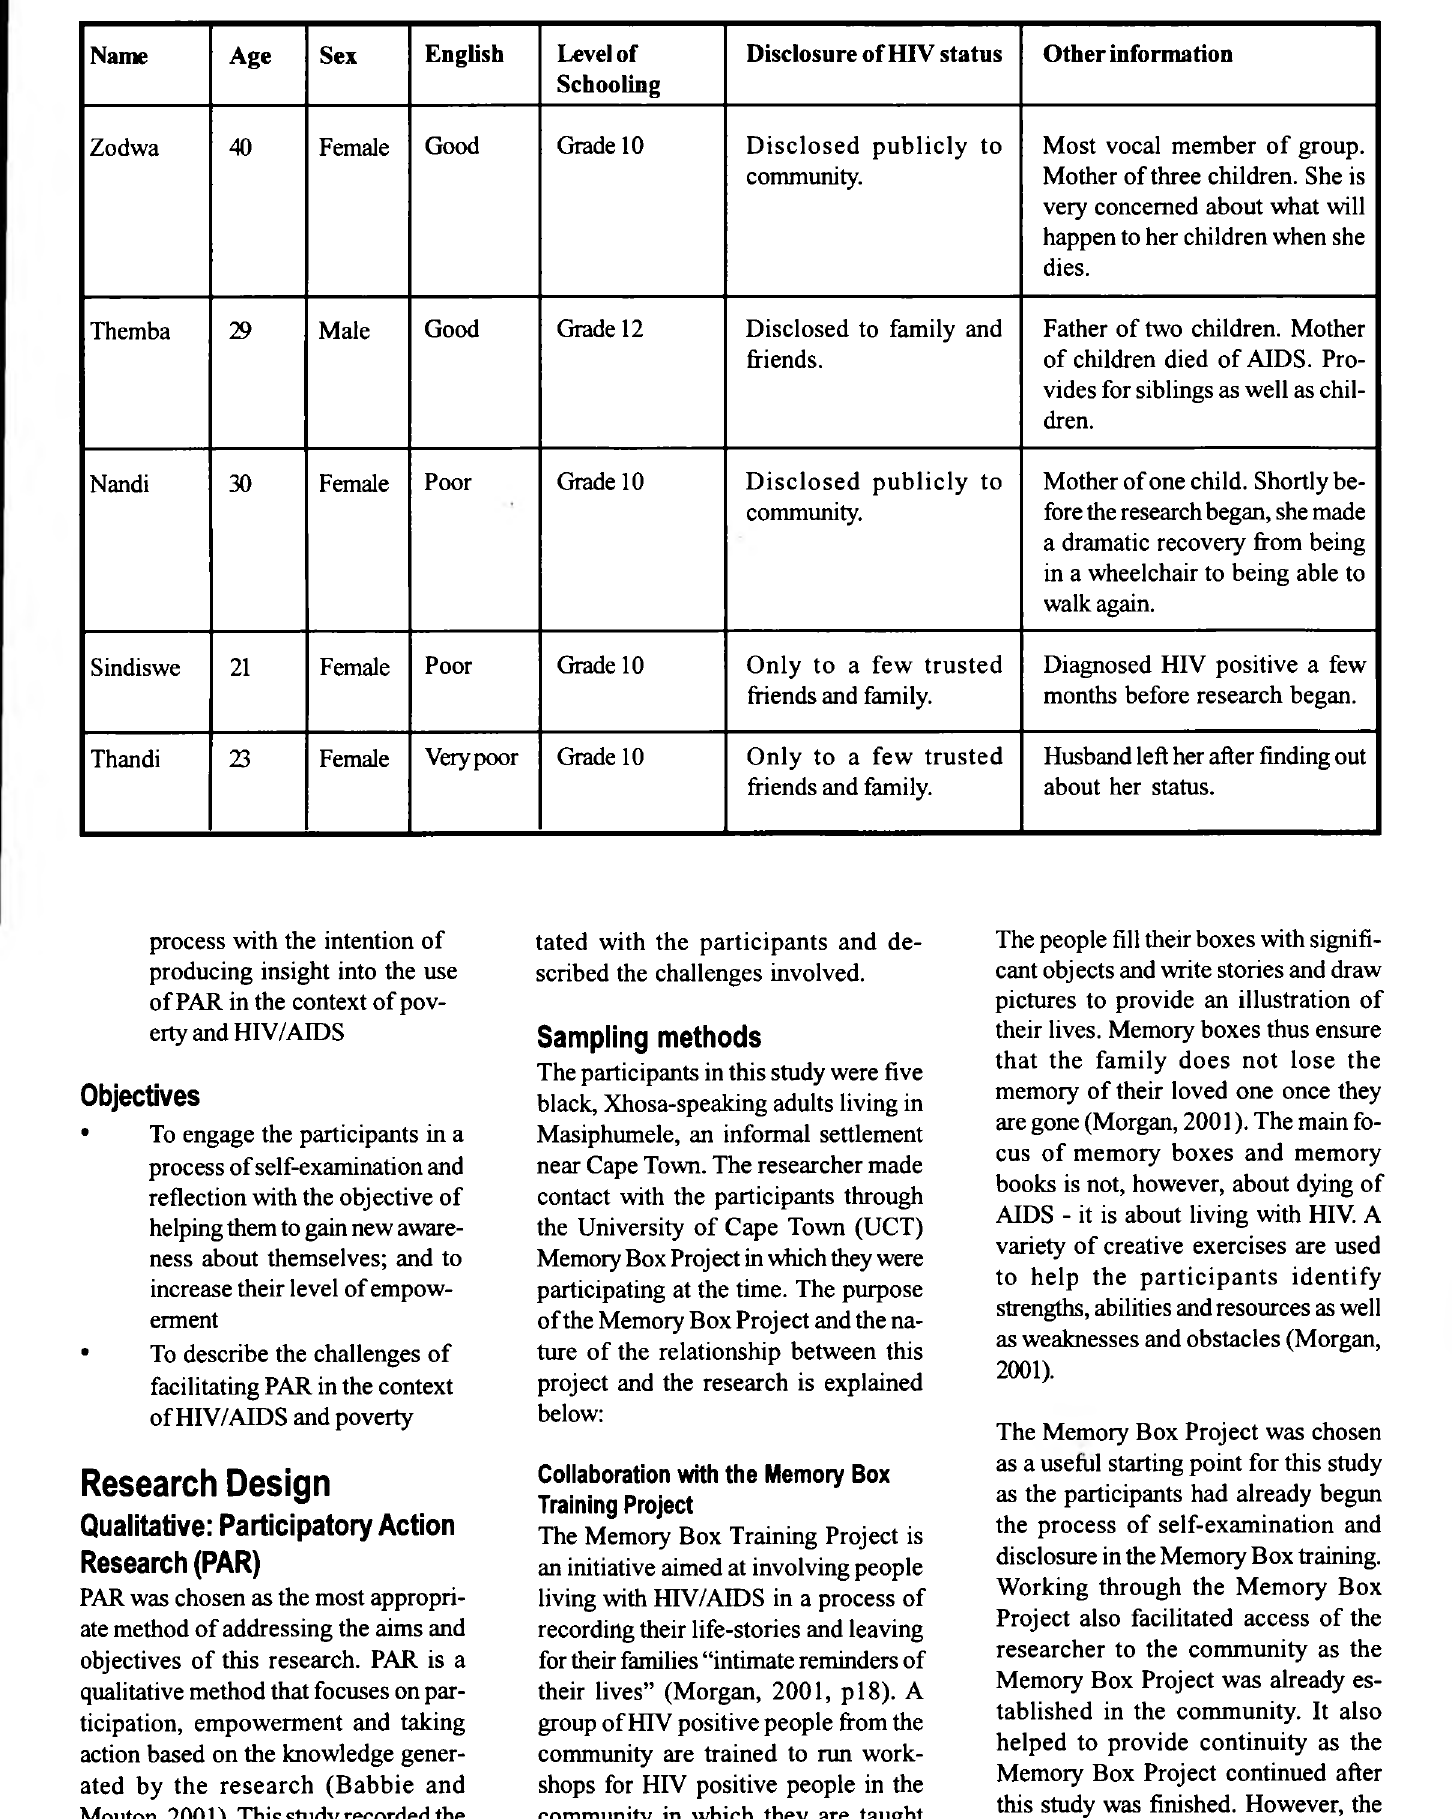
Table 1: Details of